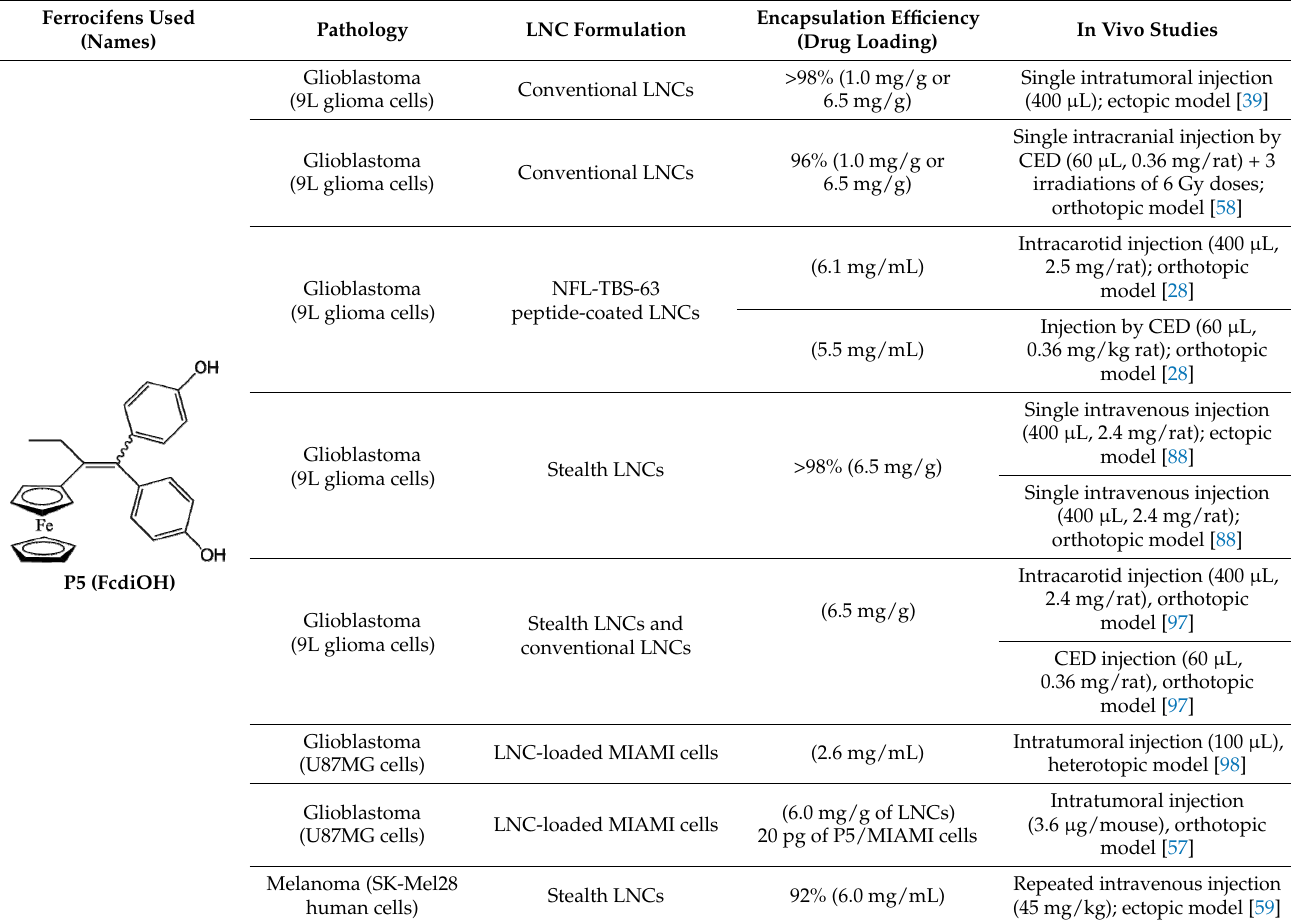
Table 4. In vivo studies performed with P5-, P15-, P53- and DP1-loaded LNCs on glioblastoma, metastatic melanoma and breast cancers.